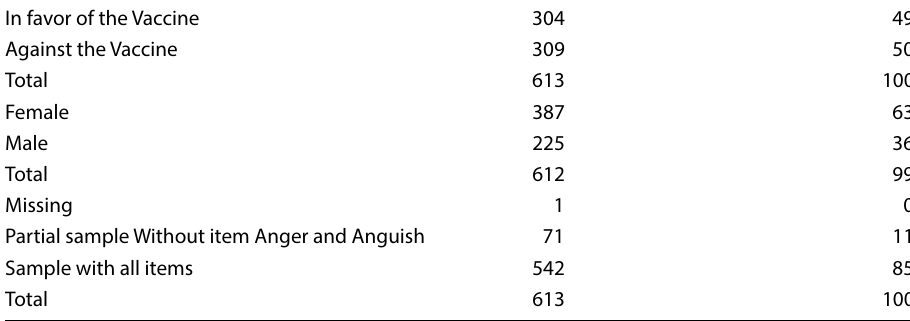
In favor of the